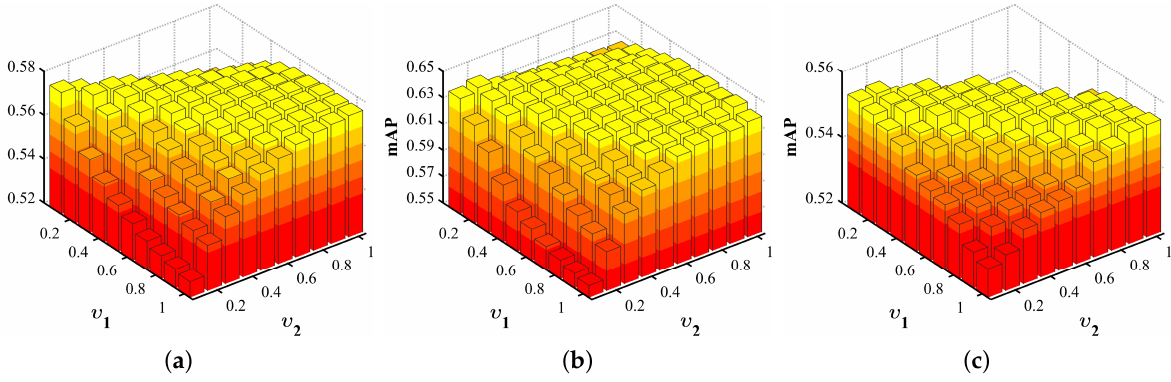
Figure 7. The mAP scores of HAAN in all datasets with ϑ 1 , ϑ 2 varying and ρ is fixed to the best value. ( a ) Corel 5K; ( b ) Pascal Sentence; ( c )